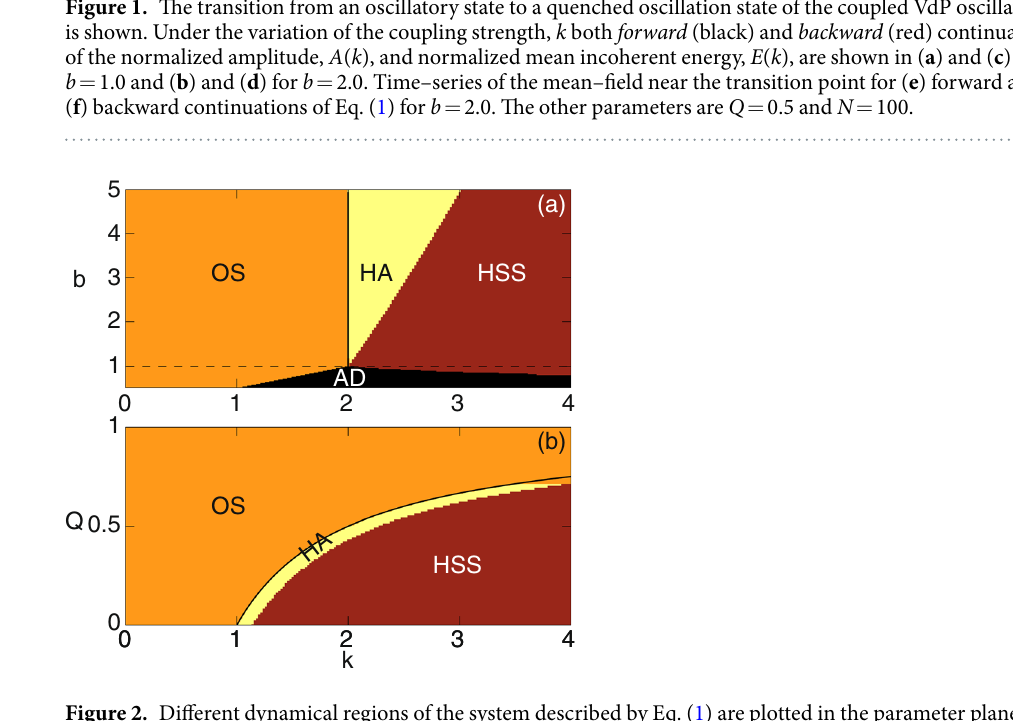
Figure 2. Different dynamical regions of the system described by Eq. (1) are plotted in the parameter planes. These dynamical regimes are observed over the range of value in ( a ) ( b − k ) parameter space at Q = 0.5, and in ( b ) ( Q − k ) parameter space at b = 2. The size of networks is N = 100. For details see the